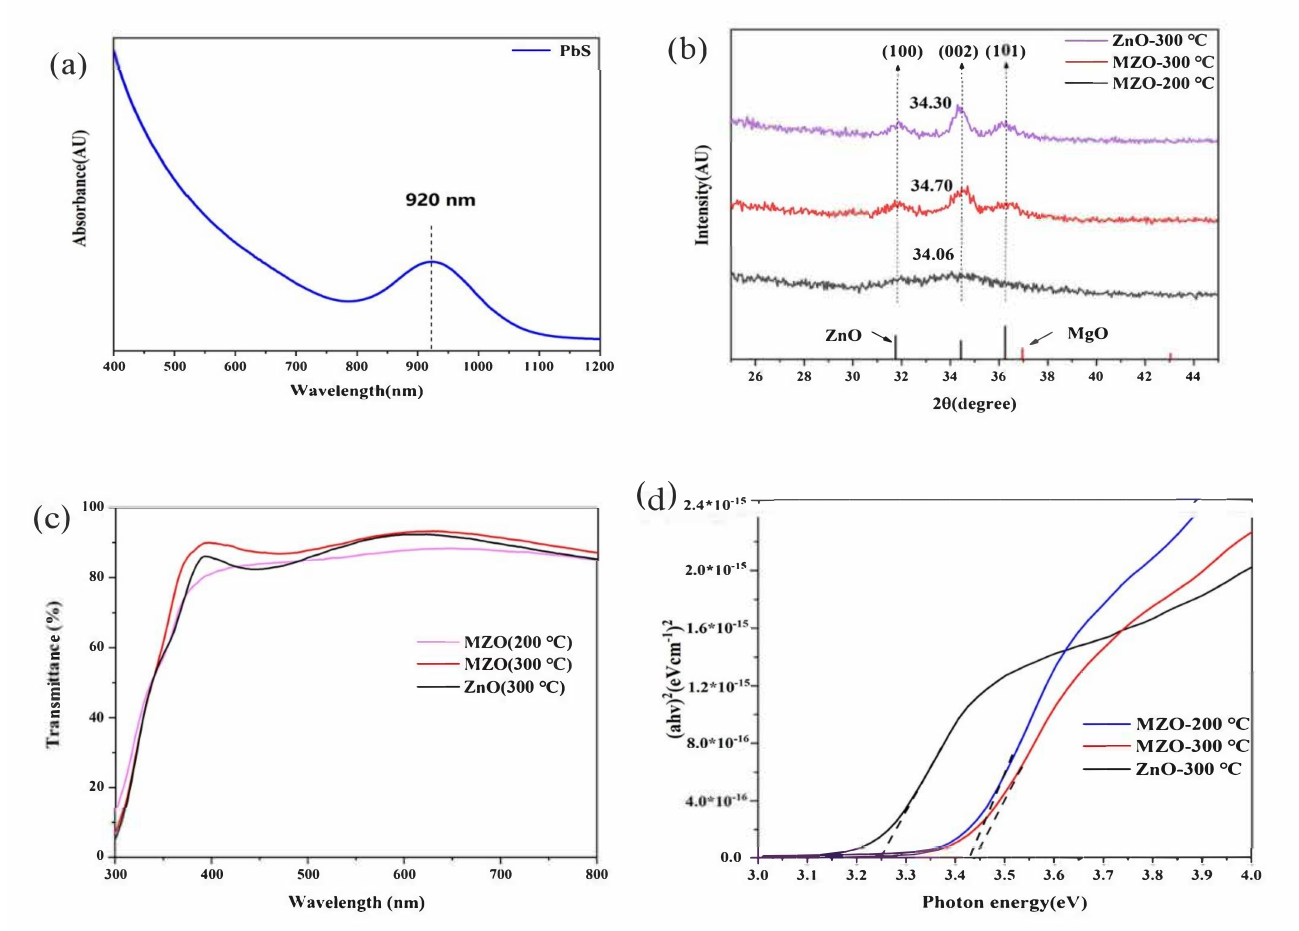
Figure 2. ( a ) Absorbance spectra of PbS CQDs for all devices listed here. ( b ) XRD pattern of ZnO and Mg-doped ZnO (MZO) thin films. ( c ) The transmission spectra of MZO with low annealing temperature (200 ◦ C) and high annealing temperature (300 ◦ C) and undoped ZnO thin film annealed at 300 ◦ C. ( d ) The plots of ( ahv ) 2 versus photon energy for MZO and ZnO thin